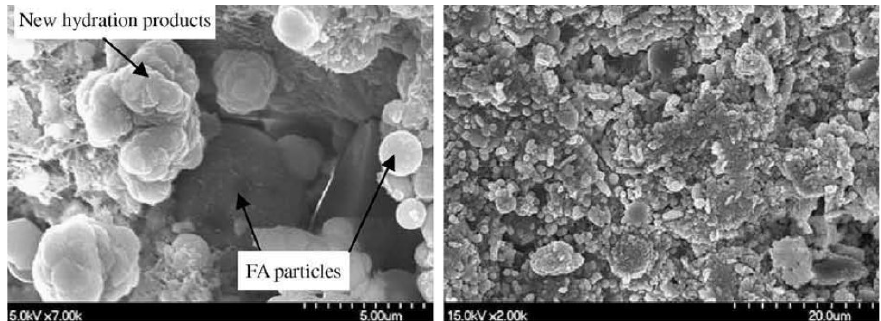
Figure 15. Surface microstructure of the concrete coated with fly ash at the curing age of 1 and 3 days [44]. Reproduced with permission from [44], Elsevier, 2010.